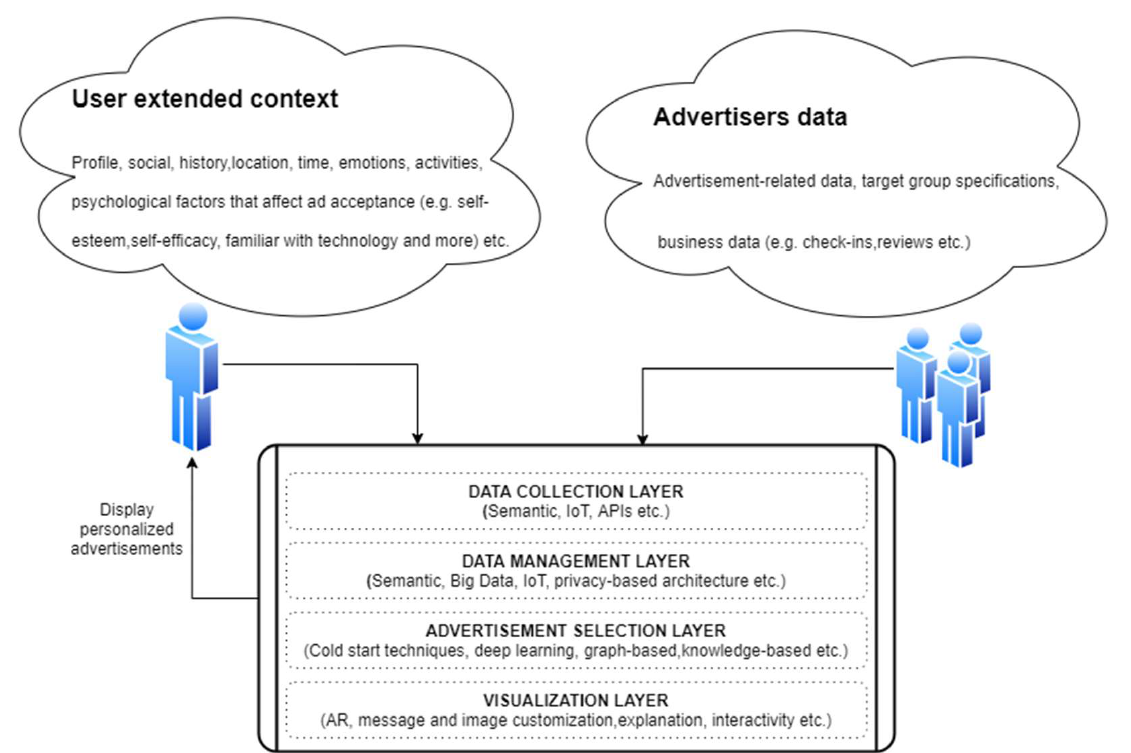
Figure 9. The design framework.